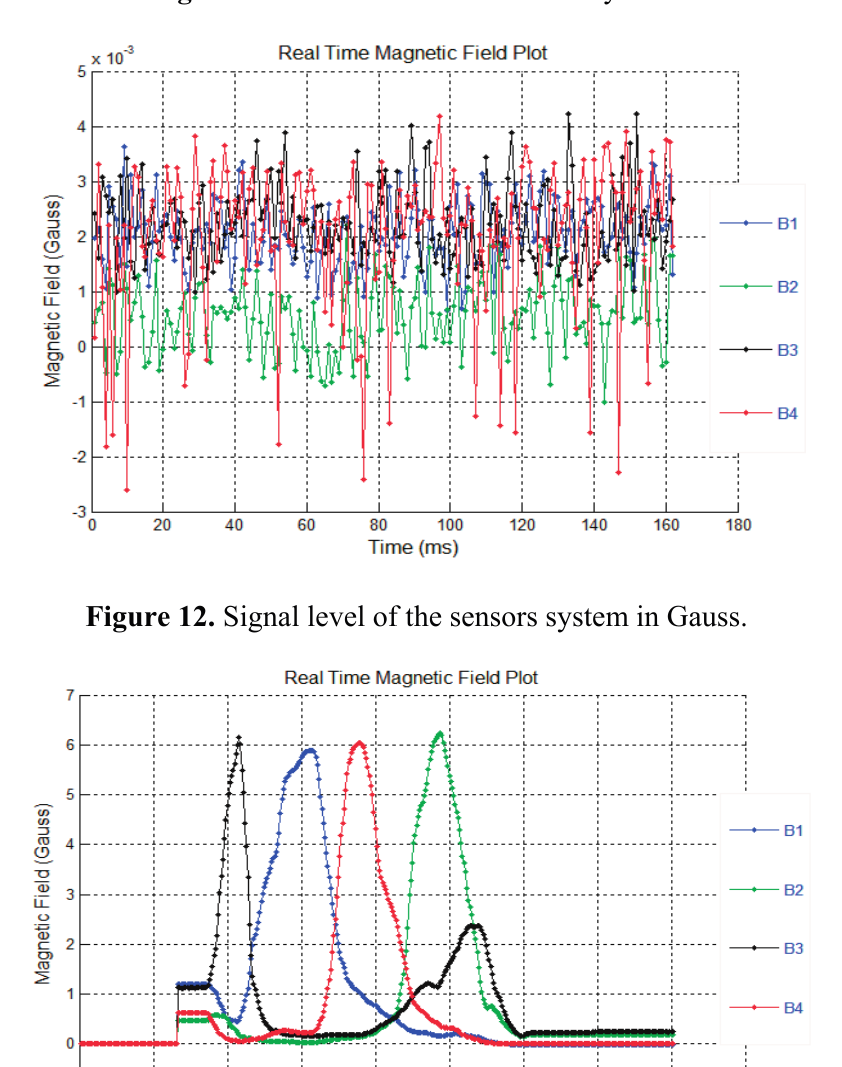
Figure 11. Noise level of the sensor system.